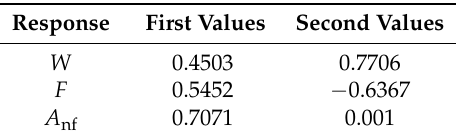
Table 9. Linear combination coefficients.